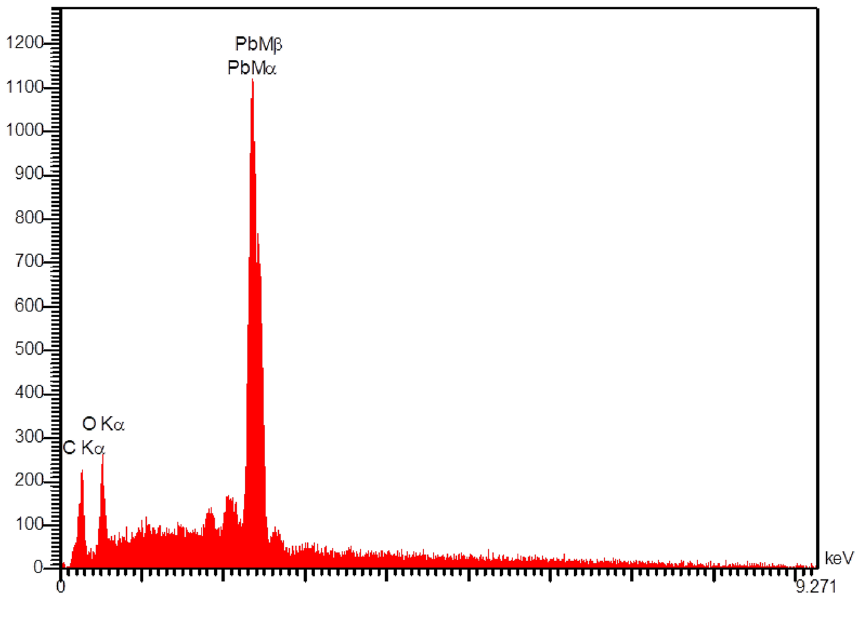
Figure 4. The EDX spectrum of PA6/PbO-10%